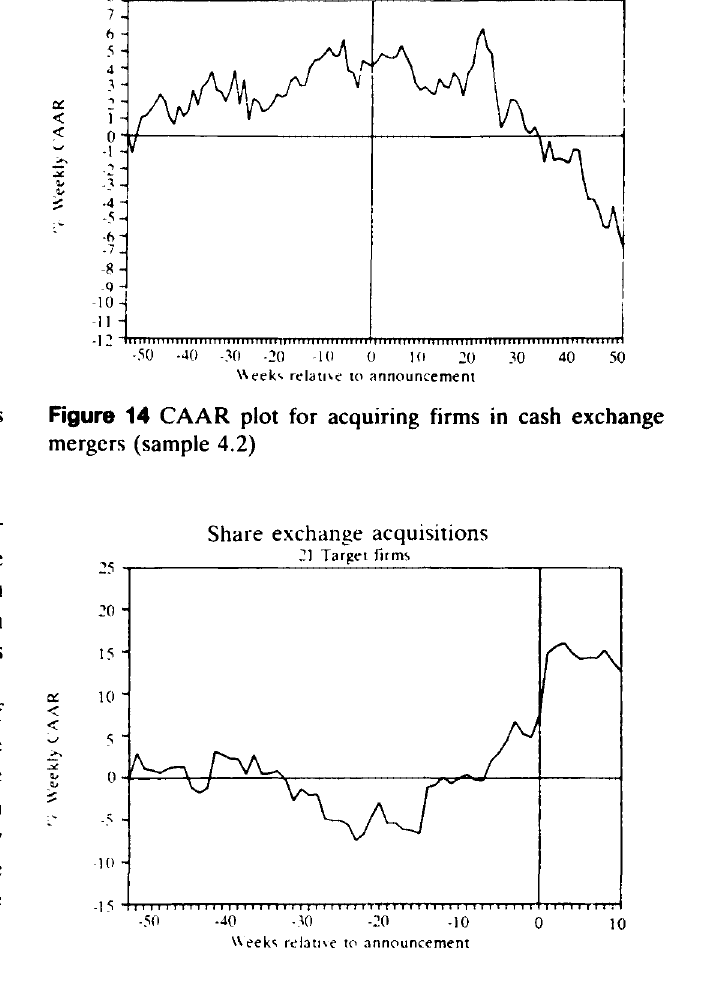
Figure 15 CAAR plot for target firms in share exchange mergers (sample